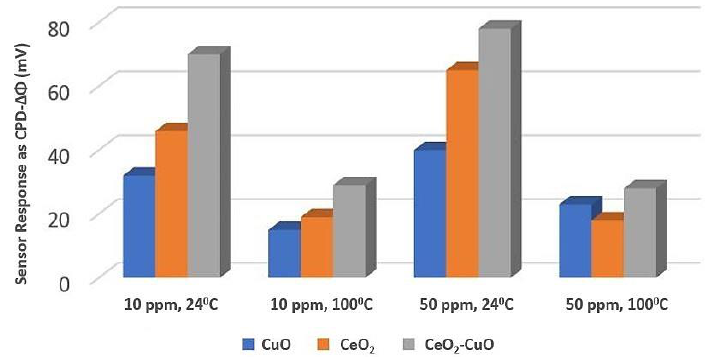
Figure 23. CeO 2 -CuO sensor response for different CO concentrations at room temperature and 100 °C.